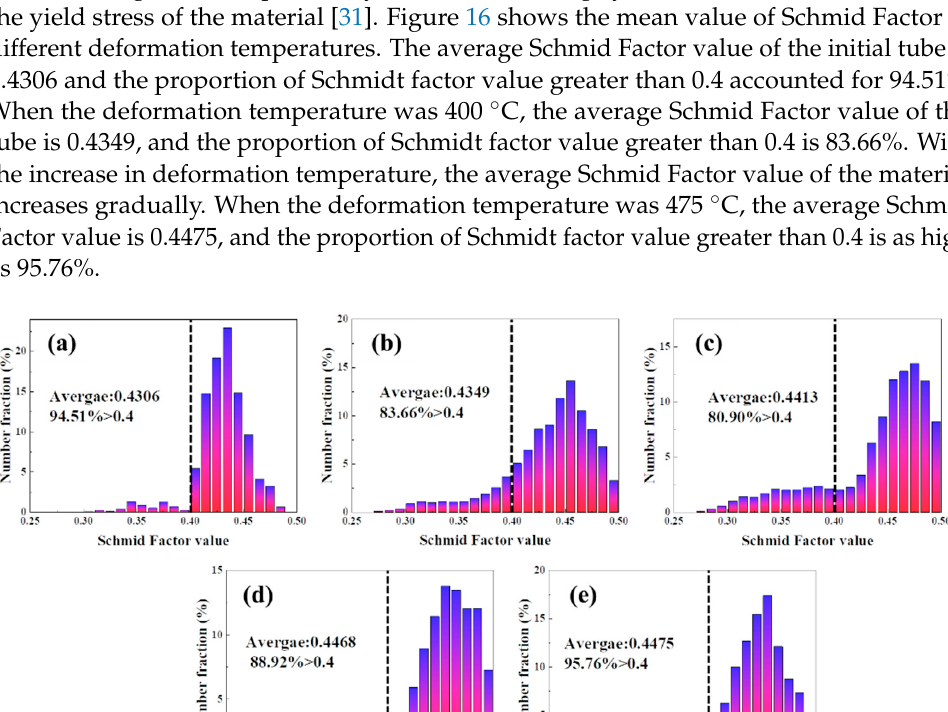
Figure 16. Schmid Factor distribution at different temperatures: ( a )original; ( b ) 400 °C; ( c ) 425 °C; ( d ) 450 °C; ( e ) 475 °C.